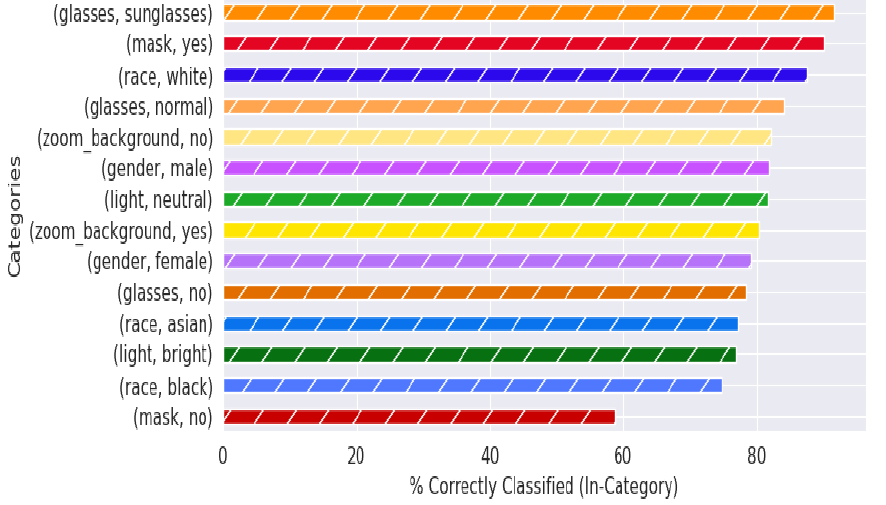
Figure 9. ‘Good’ (BRISQUE) quality image test performance with augmented MobileNetv2 model. Plot of categorical labels and classification performance with BRISQUE quality